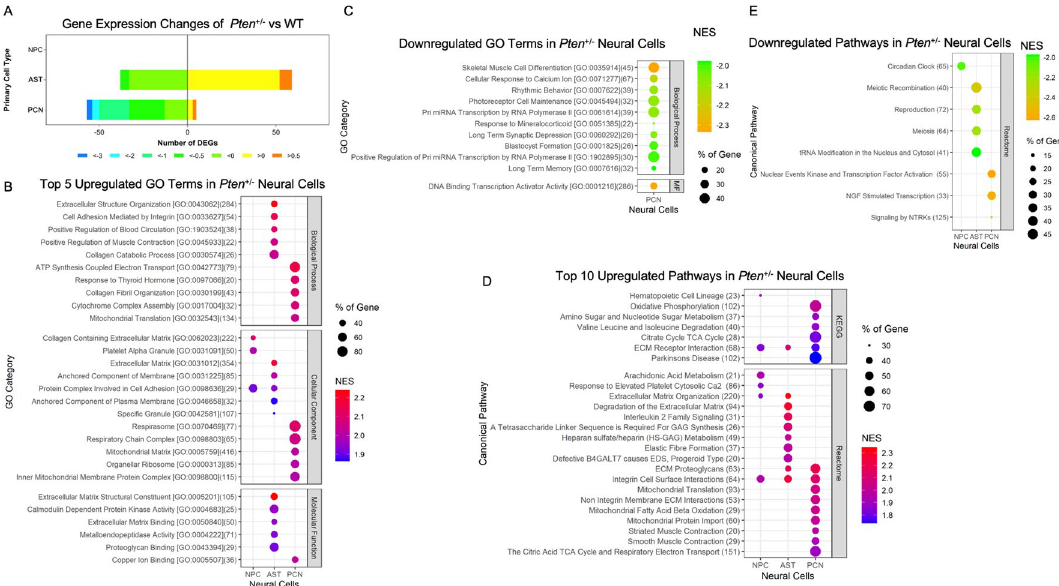
Figure 3. Transcriptomic analysis of Pten +/− primary neural cells reveals major perturbation of immediate early genes in neurons. ( A ) The differentially expressed DEGs) are stratified by the percentage fold-change in primary cultures of neural progenitor cells (NPCs), astrocytes (ASTs) and primary cortical neurons (PCNs) from Pten + / − (n = 3) and wild-type littermate control (WT) (n = 3) mice. ( B ) The five most significantly upregulated Gene Ontology (GO) terms (false discovery rate [FDR] < 0.05) enriched in Pten +/− primary neural cells. ( C ) Downregulated GO terms (FDR < 0.05) enriched in Pten +/− primary neural cells. No enriched GO terms in NPC and AST. ( D ) The 10 most significantly upregulated canonical pathways (FDR < 0.05) enriched in Pten +/− primary neural cells. ( E ) Downregulated canonical pathways (FDR < 0.05) enriched in Pten +/− primary neural